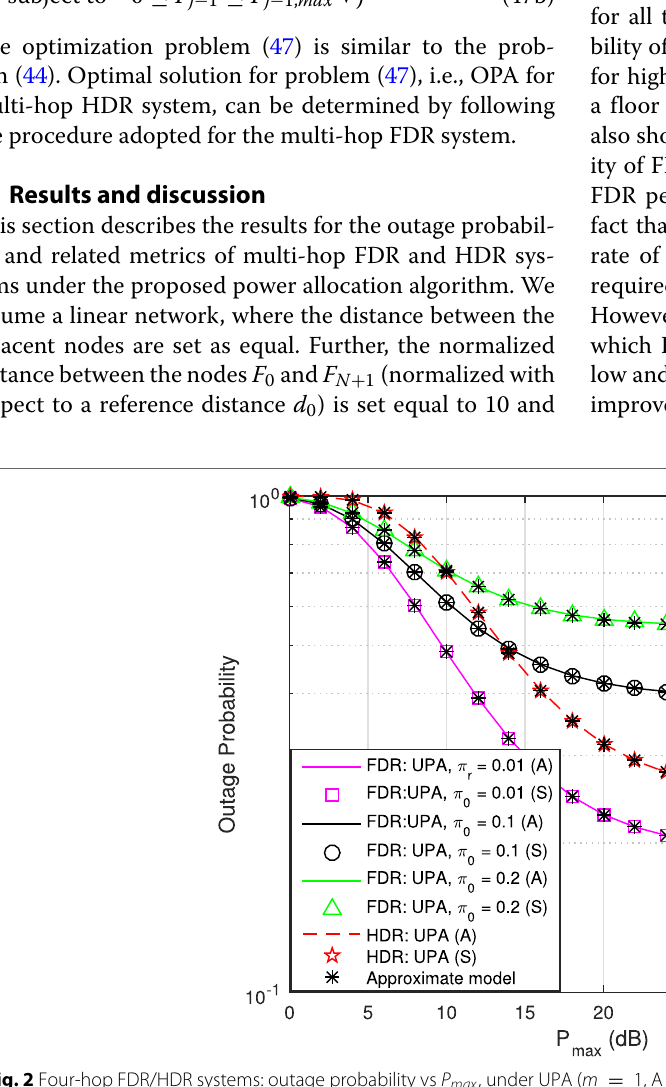
Fig. 2 Four-hop FDR/HDR systems: outage probability vs P max , under UPA ( m = 1, A analytical, S